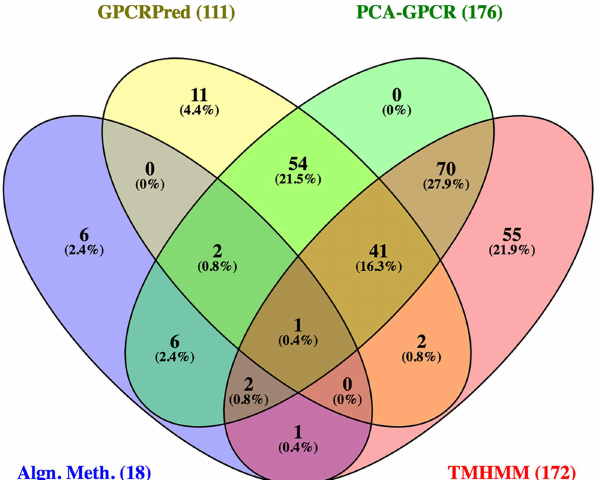
Fig 3. Venn Diagram showing numbers of GPCRs predicted by 4 different approaches: Alignment methods (Blast and Pfam), TMHMM, GPCRpred, and PCA-GPCR. The numberof total predictionsby each approach is indicatedin